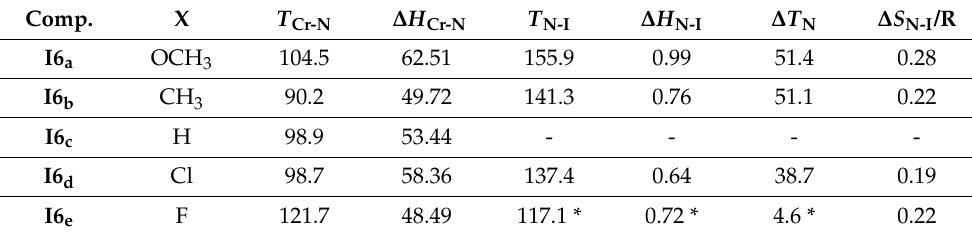
Table 1. Mesomorphic transition temperatures ( ◦ C), enthalpy of transition ∆ H , kJ/mole, mesophase range ( ∆ T ) and the normalized entropy of transition ∆ S/R for analogues series I6 a–e upon heating cycle.